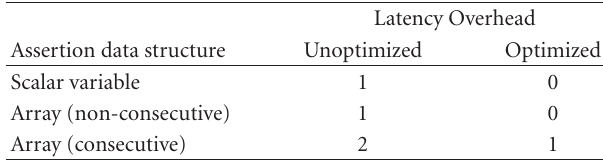
Table 2: Edge-detection assertion overhead. Table 3: Single-comparison assertion.